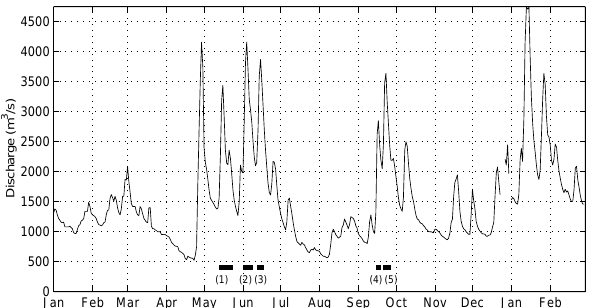
Fig. 10. Po River discharge for the period of May 1995 to February 1996. The pulses in the Po River discharge analysed in the text are